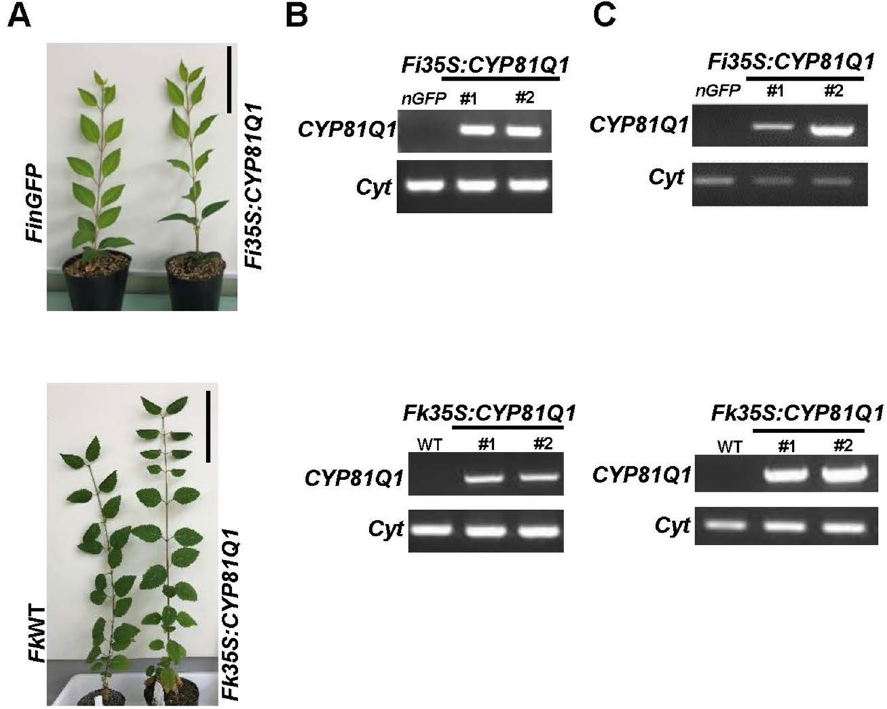
Figure 3. Generation of transgenic Pro35S:CYP81Q1 plants. ( A ) Control and Pro35S:CYP81Q1 plants. Scale bars = 10 cm. ( B , C ) Genomic ( B ) and reverse transcribed (RT)-PCR ( C ) analyses of CYP81Q1 gene. Cyt (cytochrome) served as an internal control. The numbers above the gel images indicate the plant lines regenerated from independent